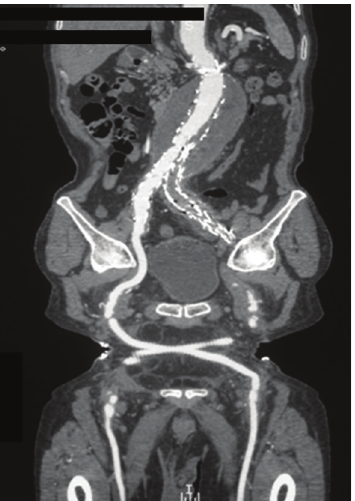
Figure 4: Complete exclusion of the aneurysm on CT angiography one month